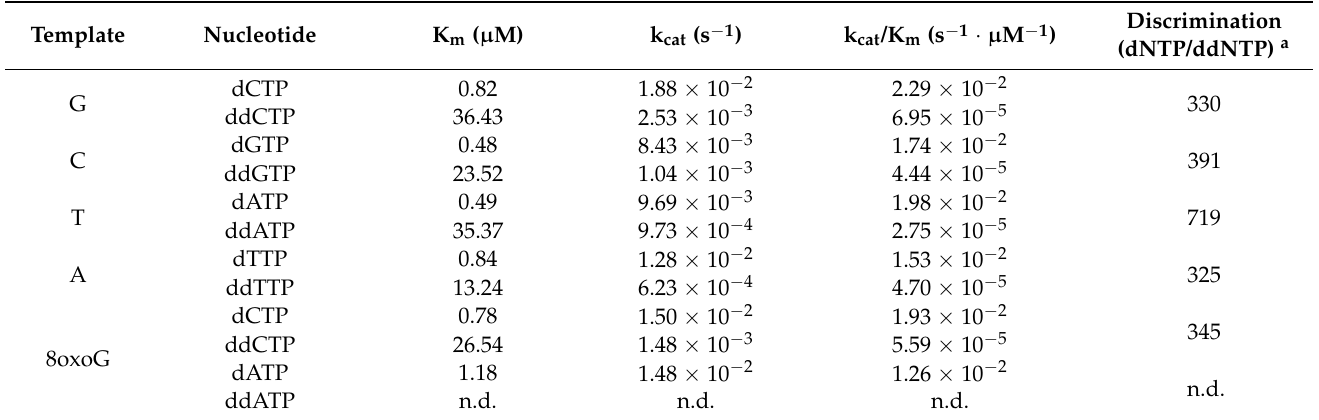
Table 1. Kinetic parameters for dNTP or ddNTP incorporation opposite the complementary template base (G, C, T, A and